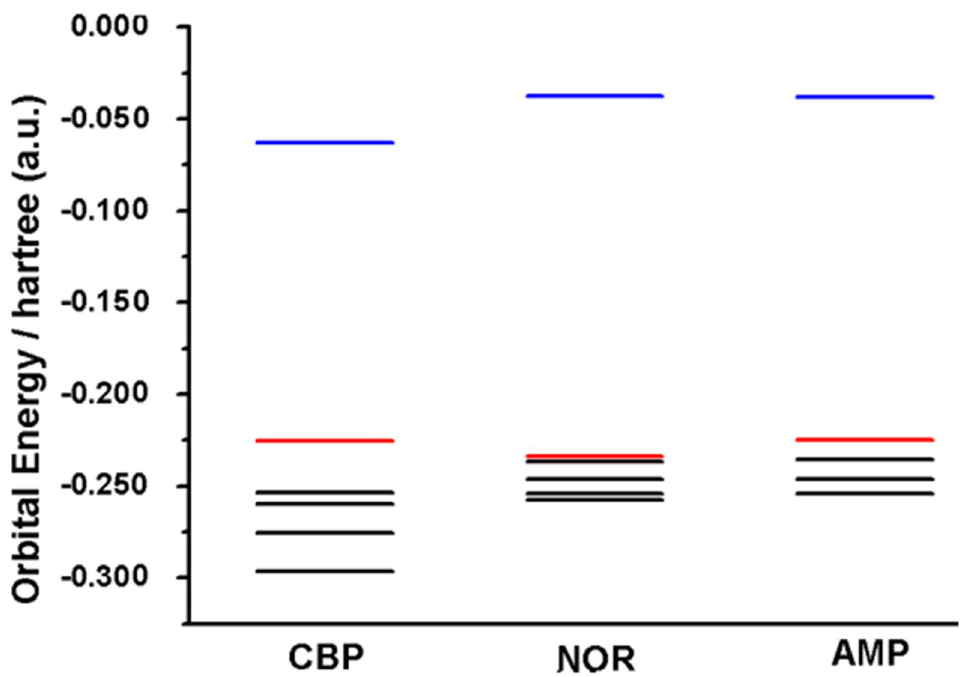
Figure 6. Orbital energy plot of CBP, NOR and AMP, depicting the LUMO (blue line), HOMO (red line) and lower occupied orbitals (black lines).